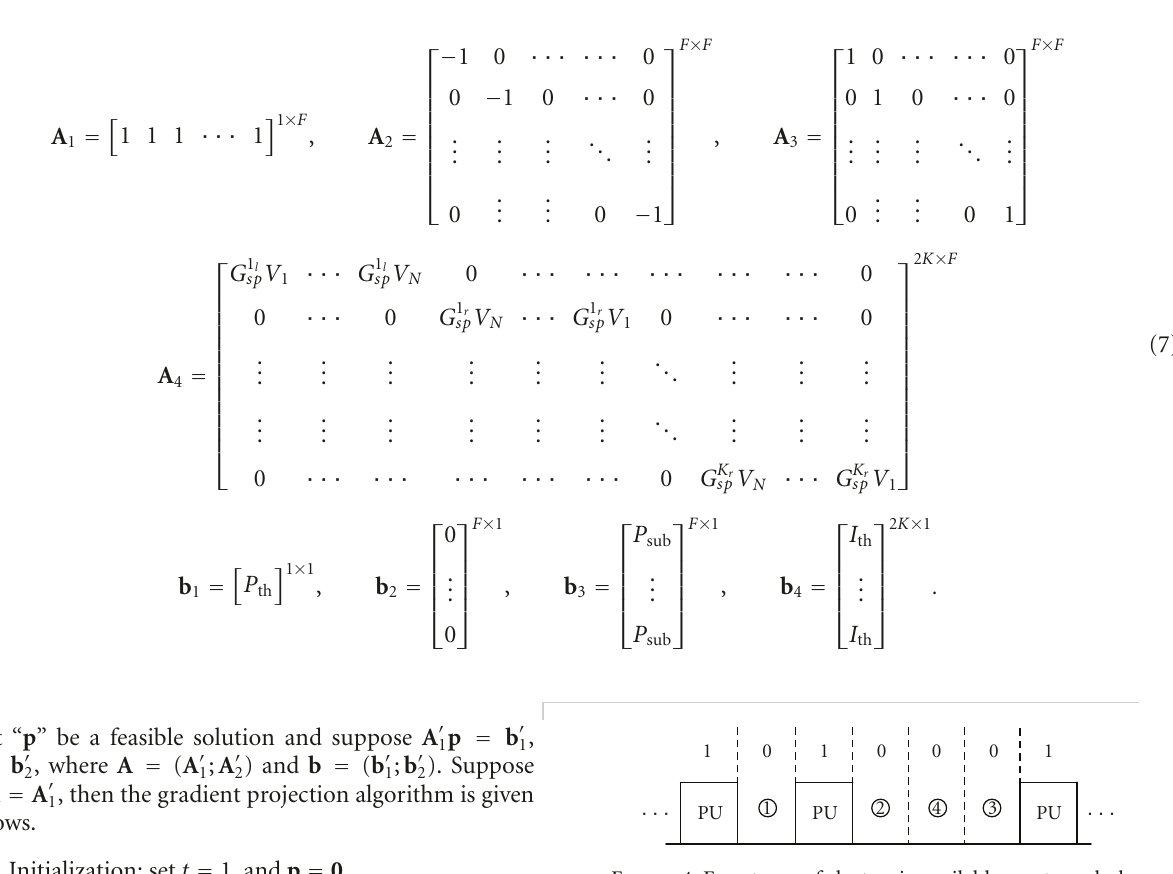
Figure 4: Four types of clusters in available spectrum